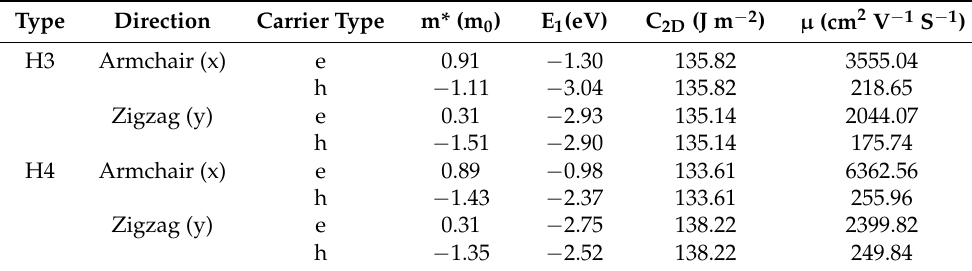
Table 3. Values of effective mass (m*), deformation potential constant (E 1 ), elastic modulus (C 2D ), and carrier mobility ( µ ) for H4 heterojunction along the transport directions obtained by the PBE functional; x and y represent armchair and zigzag directions, respectively. The temperature was set at 300 K.